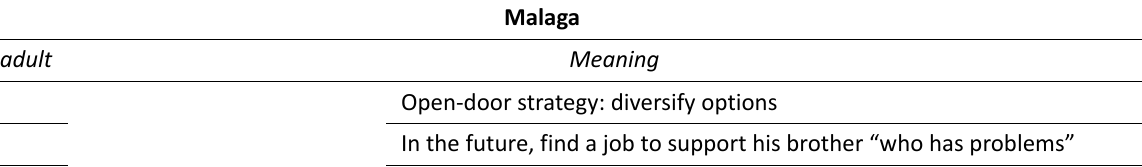
Table 3. Meaning behind the decision to enrol in an LLL programme: Perceived opportunities.